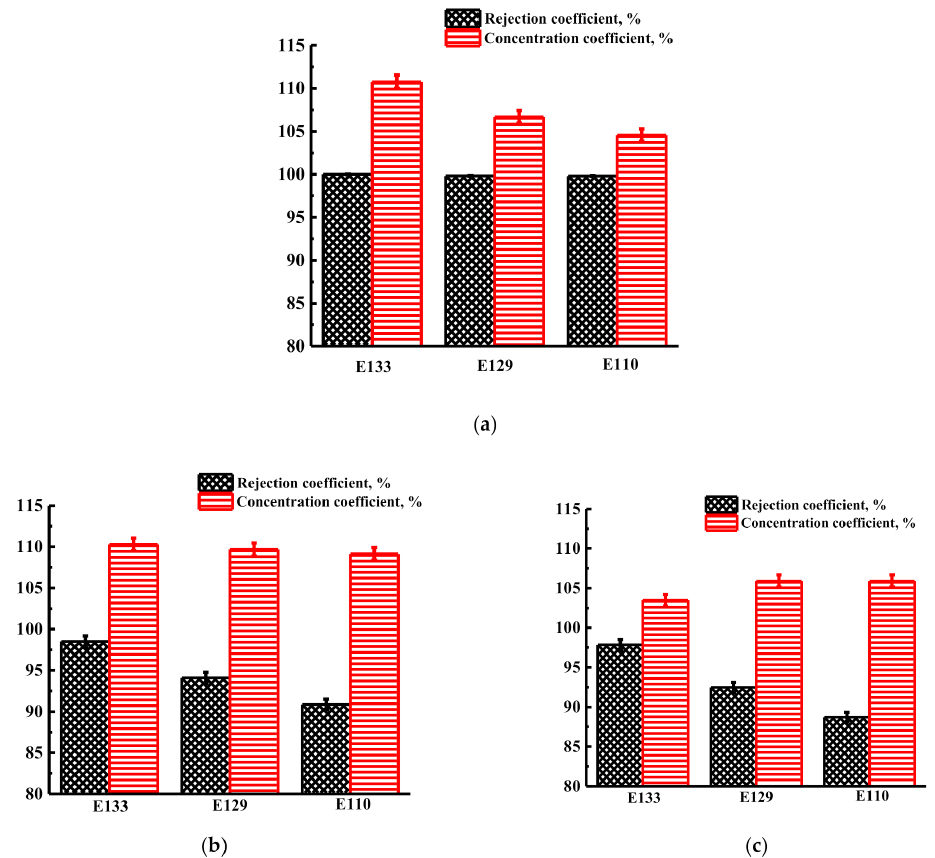
Figure 12. The rejection and concentration coefficients of food dyes (E110, E129, and E133) for ( a ) PIM-1, ( b ) PIM-1/MIL-125, and ( c ) PIM-1/MIL-140A membranes during the nanofiltration of dissolved caramel in a mixture of water/ethanol (50/50 vol.%) at 50